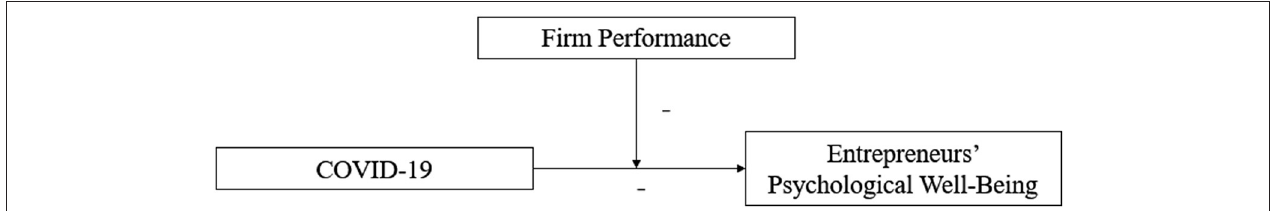
FIGURE 1 | Theoretical model.